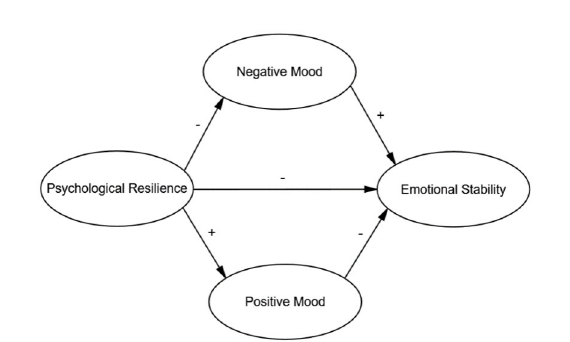
FIGURE1 Hypothetical model of the relationship between psychological resilience and emotional stability of high school students. The minus sign between psychological resilience and negative mood indicates that psychological resilience negatively affects the negative mood state; thus higher levels of individual psychological resilience are associated with less negative mood states. The positive sign between psychological resilience and positive mood indicates that psychological resilience positively affects positive mood states; thus, higher levels of individual psychological resilience are associated with more positive emotions. Psychological resilience has a negative impact on emotional stability; thus the higher the level of individual psychological resilience, the more stable the emotions are. Negative mood states positively affect emotional stability; thus the more negative moods an individual has, the more unstable the individual’s emotions are. Positive mood negatively affects emotional stability; thus, the more positive moods an individual has, the more stable the individual’s emotions will